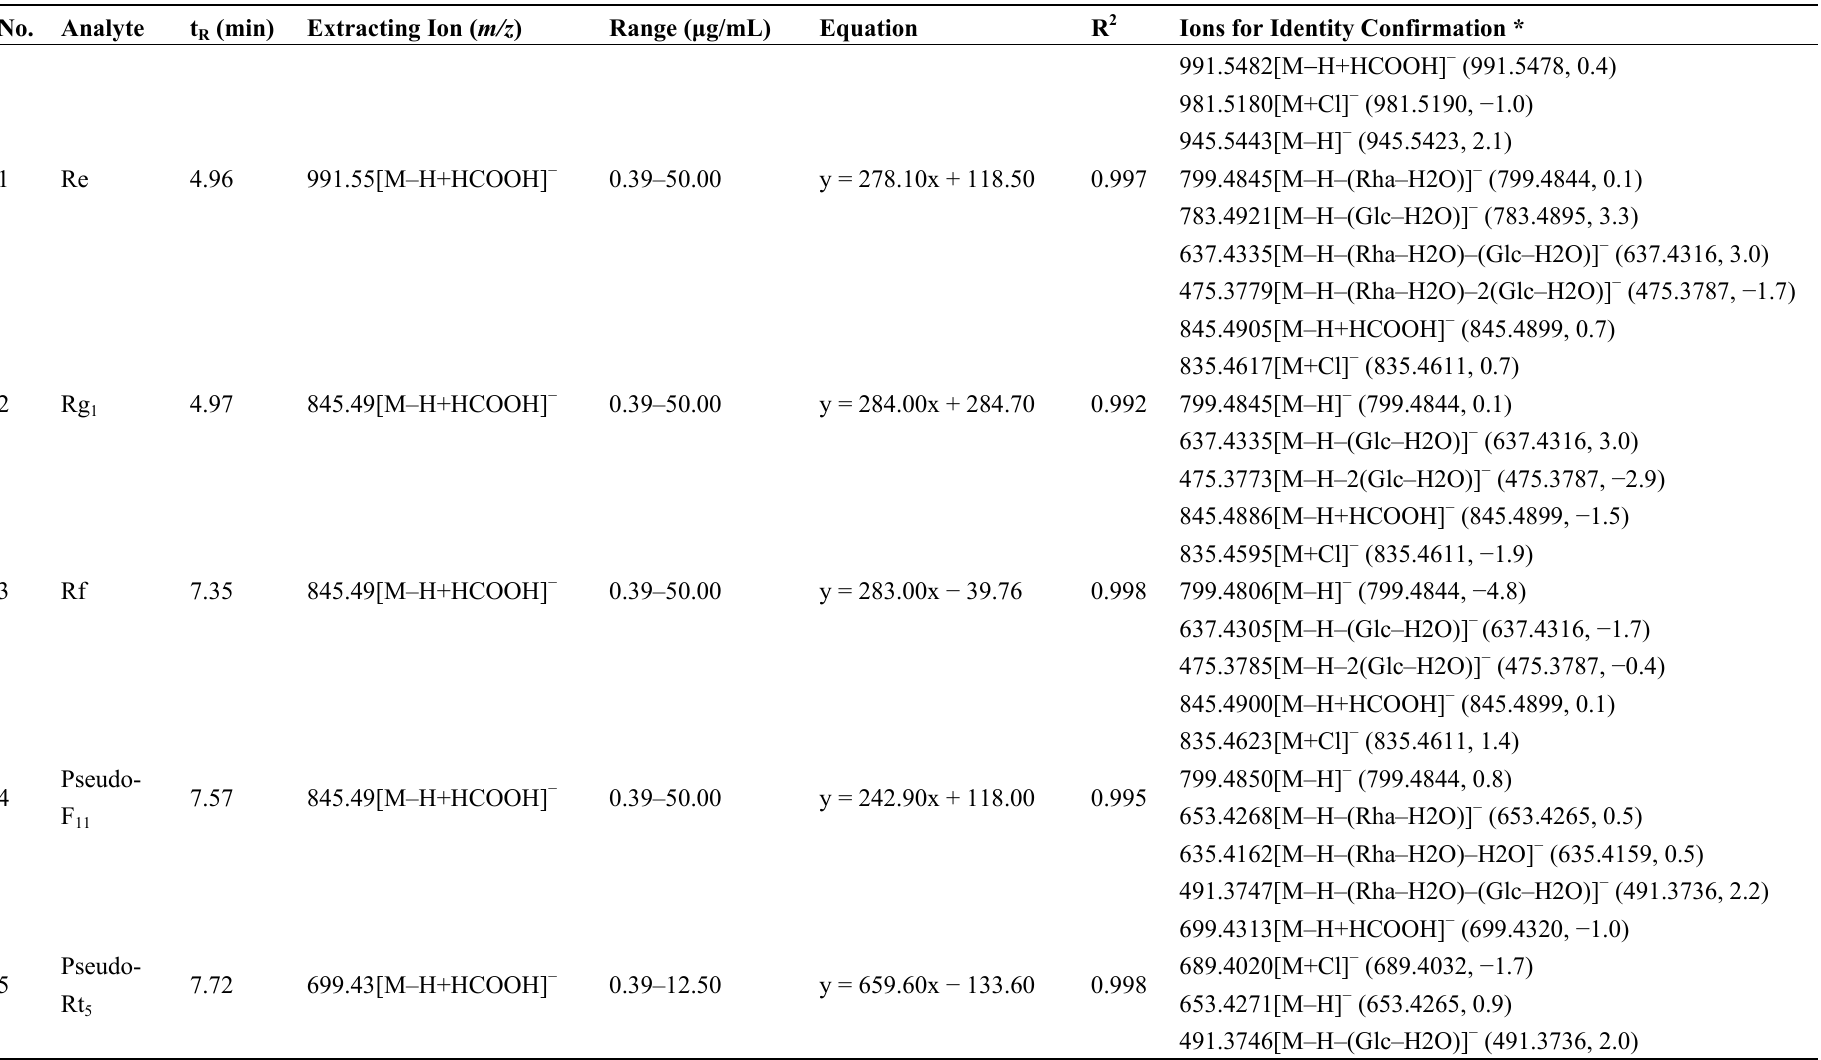
Table 1. Retention times, extracting ions for quantification, calibration curves and ions for identity confirmation of 30 analytes.